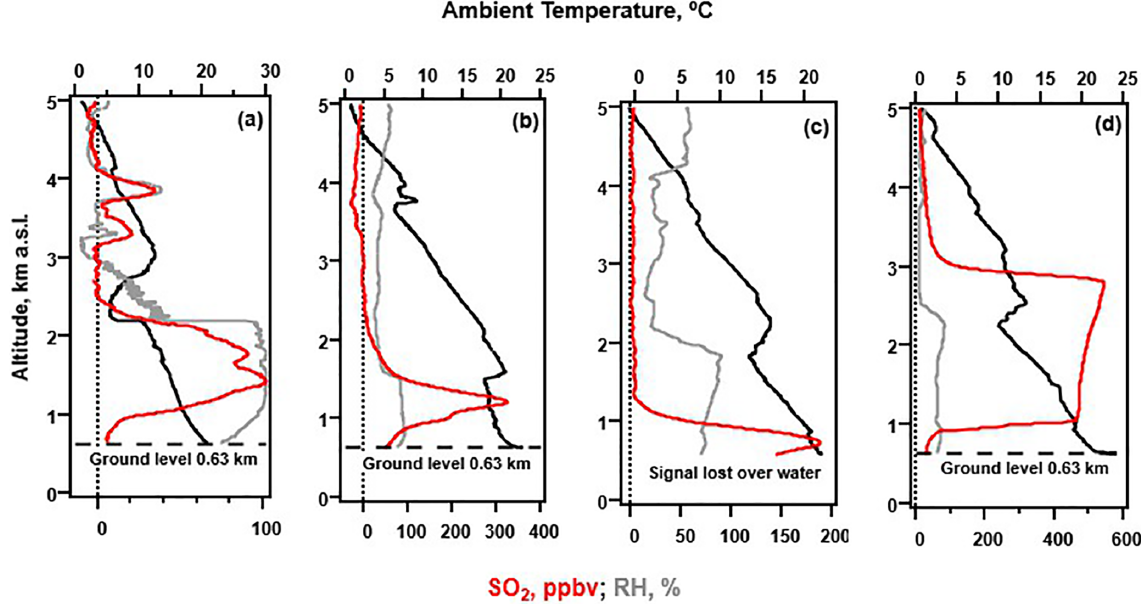
Figure 8. Vertical profiles of SO 2 (20s box smoothing) from the SO 2 sonde v1.1 during BISOS in June 2018 with free-release balloon launches occurring at the Kahuku Ranch on the big island of Hawai’i. Profiles are from (a) 22 June 2018 00:32, (b) 28 June 2018 20:45, (c) 29 June 2018 21:36, and (d) 30 June 2018 20:48. All times are UTC.